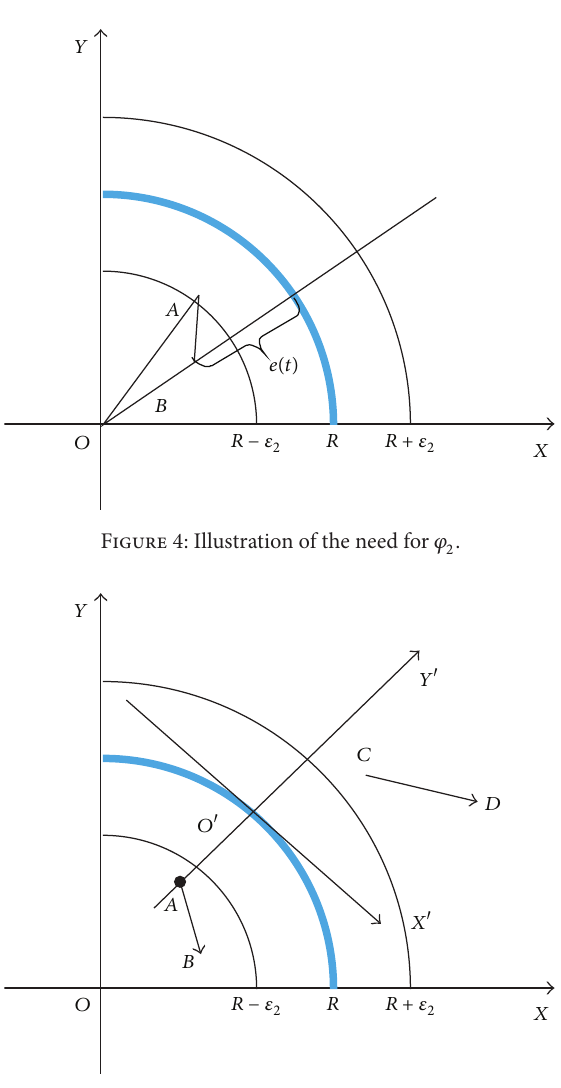
Figure 5: Illustration of the need for 𝜑 3